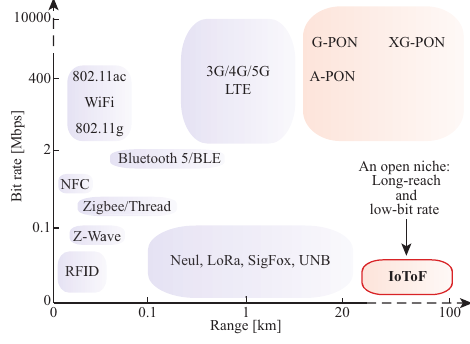
Figure 1. Relation between bandwidth and range for wireless IoT standards and passive optical networks (PONs)-based communication networks with the inclusion of the IoToF concept here